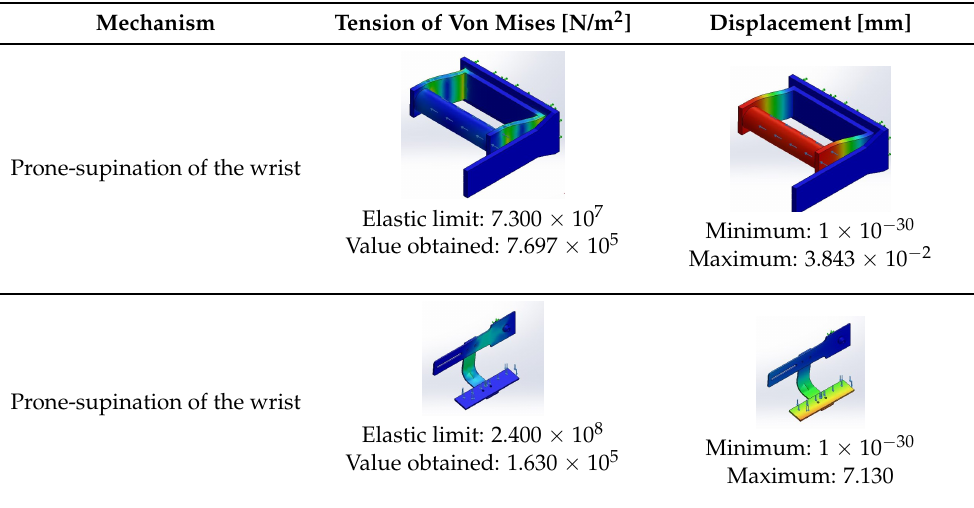
Table 3. Stress analysis of the mechanisms of the prototype orthosis to support upper torso